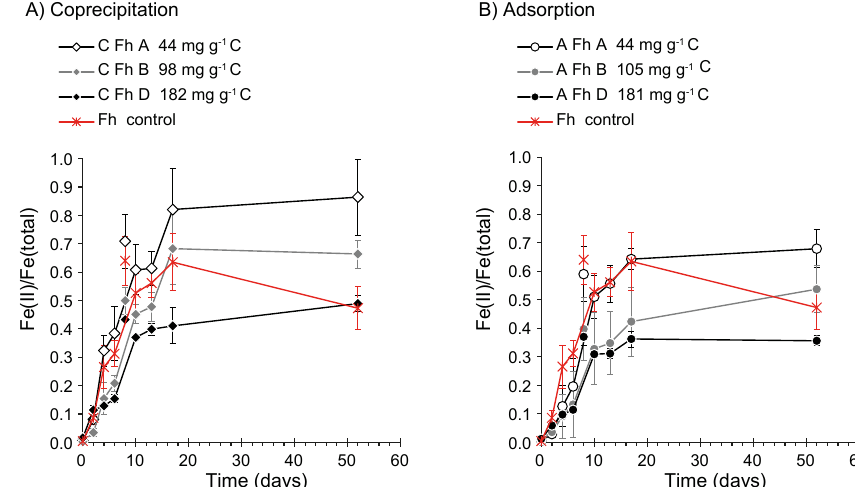
Figure 6. Microbial reduction of ferrihydrite and ferrihydrite-organic matter associations in Geobacter bremensis cultures. The Fe(II) pro- duction was normalized to the total initial amount of Fe in ferrihydrite. The Fe(II)/Fe(total) of the ferrihydrite control (red stars) at day 52 was much lower than at day 17 and therefore unexpectedly low, leading us to assume that this was due to unintentional oxidation at the end of the experiment in this sample (further details see text). Error bars represent standard deviations of triplicate